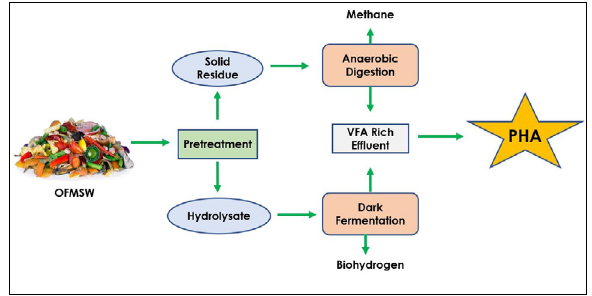
A simplified schematic of a bioplastic biorefinery.